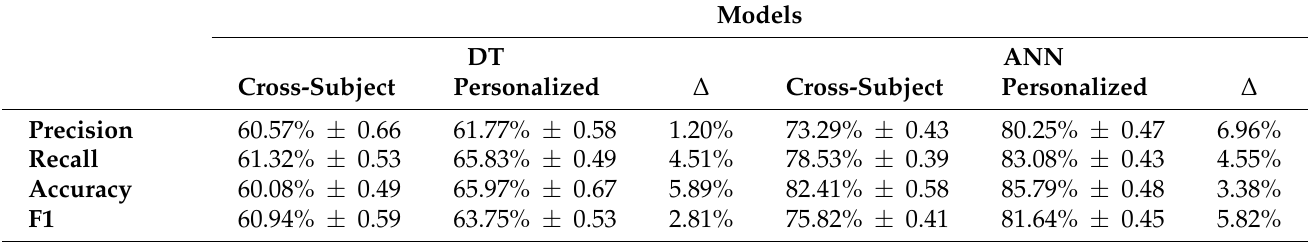
Table 4. Average precision, recall, and accuracy, with a CI of 95%, for detecting fatigue in biceps repetitions before and after the personalization of cross-subject